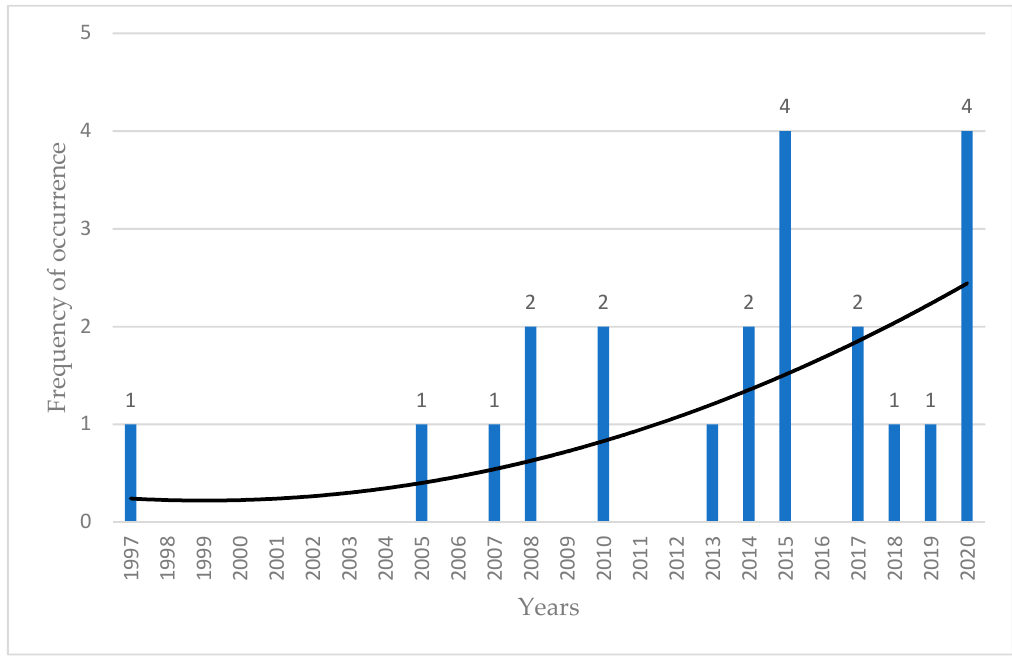
Figure 2. Annual scientific production of thermal comfort studies in bus cabin environments.